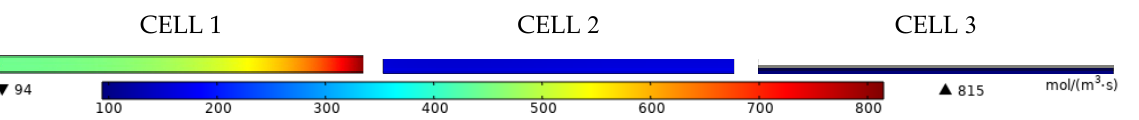
Figure 5. Reaction rate distribution of dry reforming along catalyst layers from top to bottom in mol/(m 3 .s).